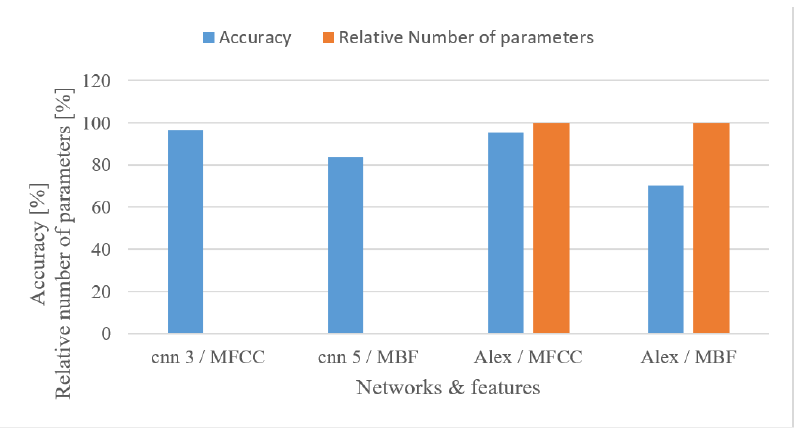
Figure 21. Accuracies and relative numbers of trainable parameters for 3- and 5-layer custom CNNs (CNN 3, CNN 5), and the Alexnet for MFCC and MFB features.